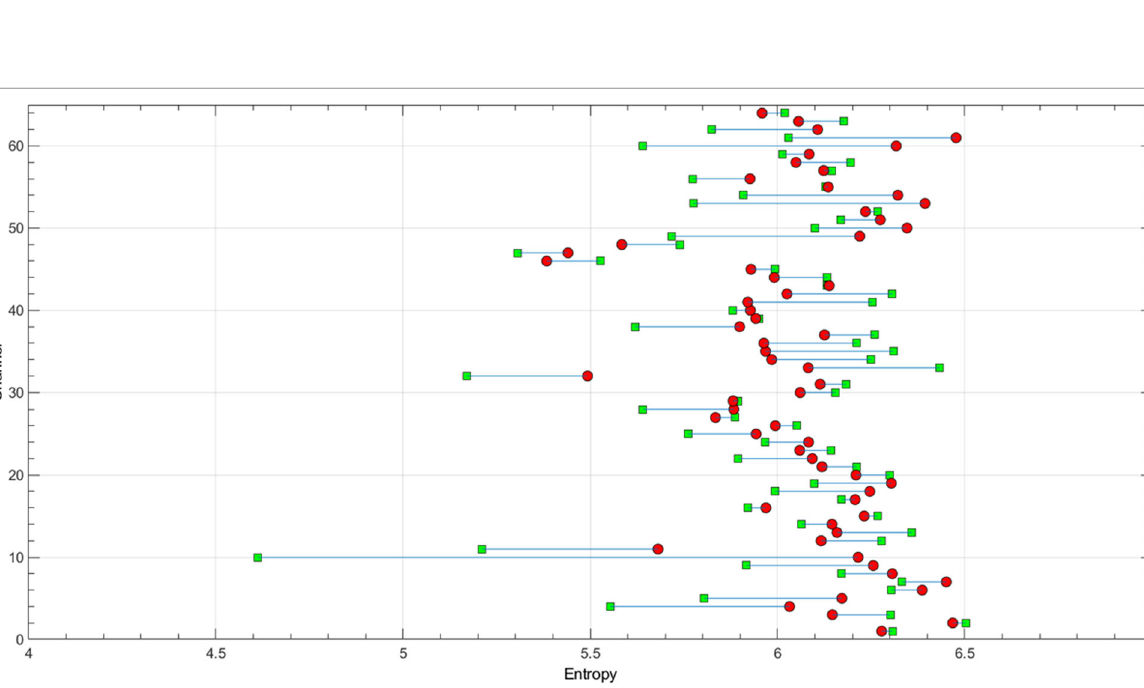
Fig. 12 Change in global Rényi entropy before and after RICI for average of ERPs at each